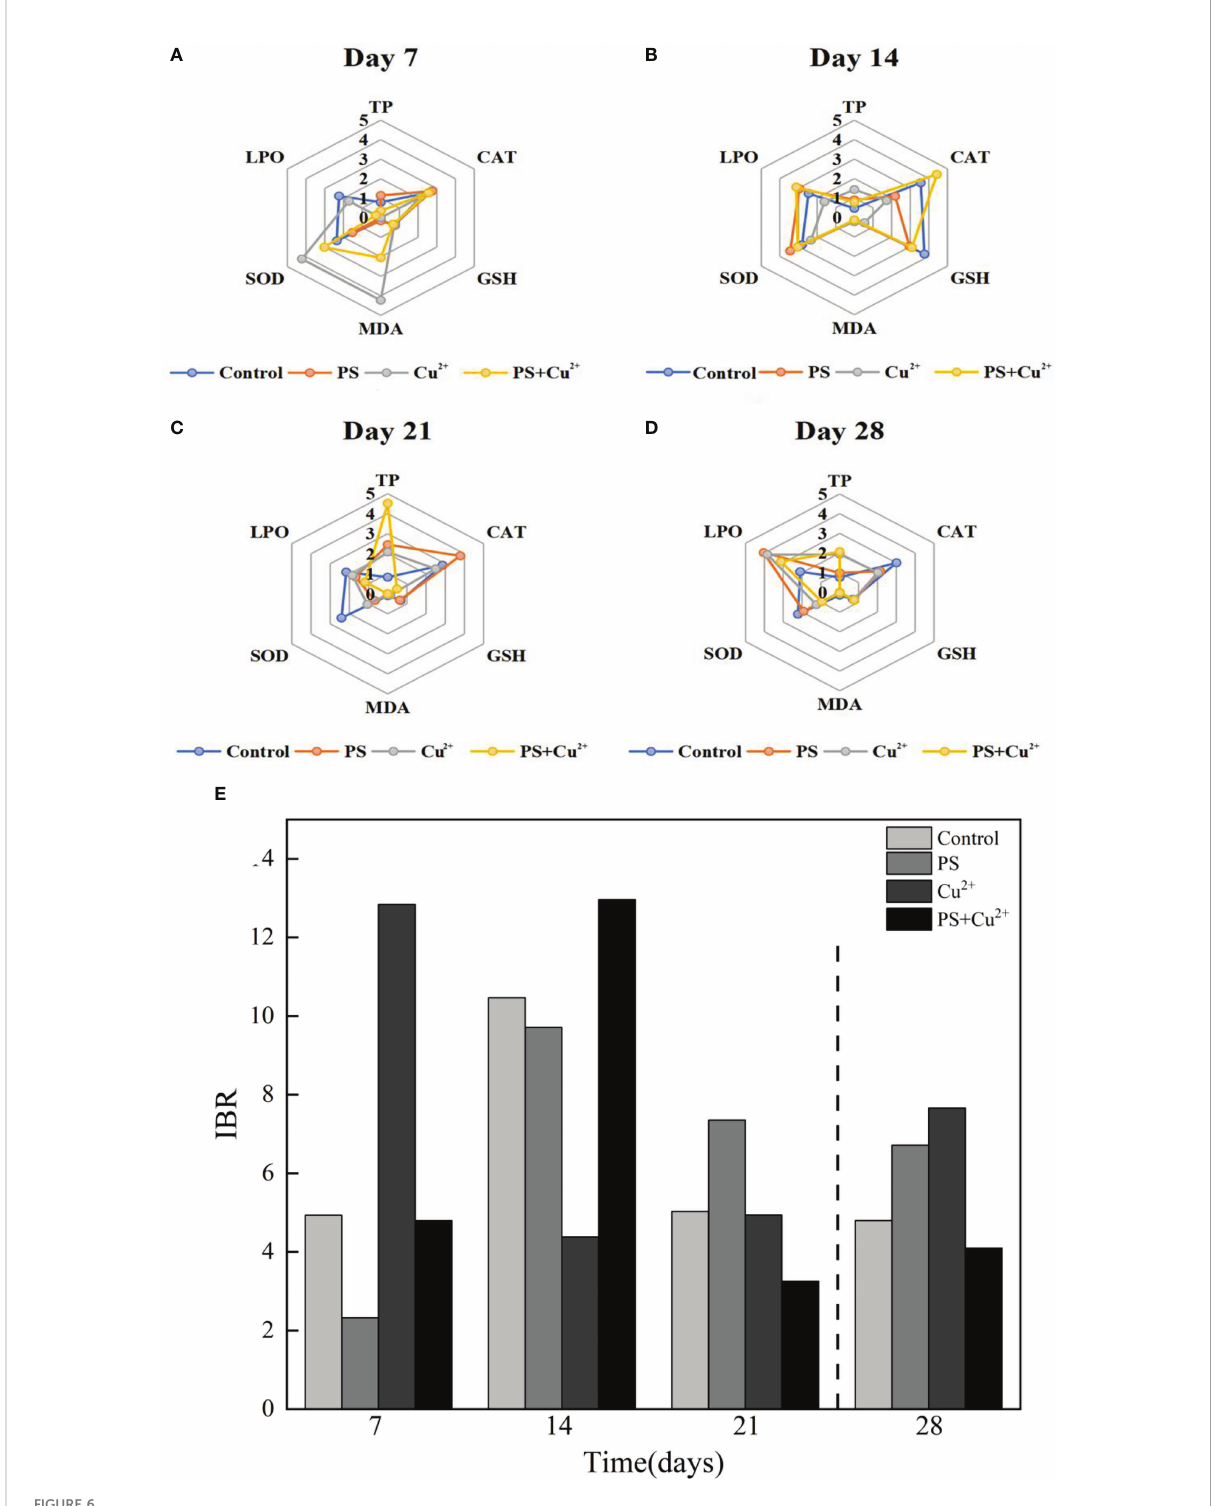
FIGURE 6 (A – D) represent radar plots of IBR for different treatments of experimental juvenile horseshoe crabs on days 7, 14, 21, and 28, respectively, showing the stress levels as indicated by antioxidant parameter levels in the graphs. (E) represents the stress levels presented by different groups of experimental horseshoe crabs throughout the experimental